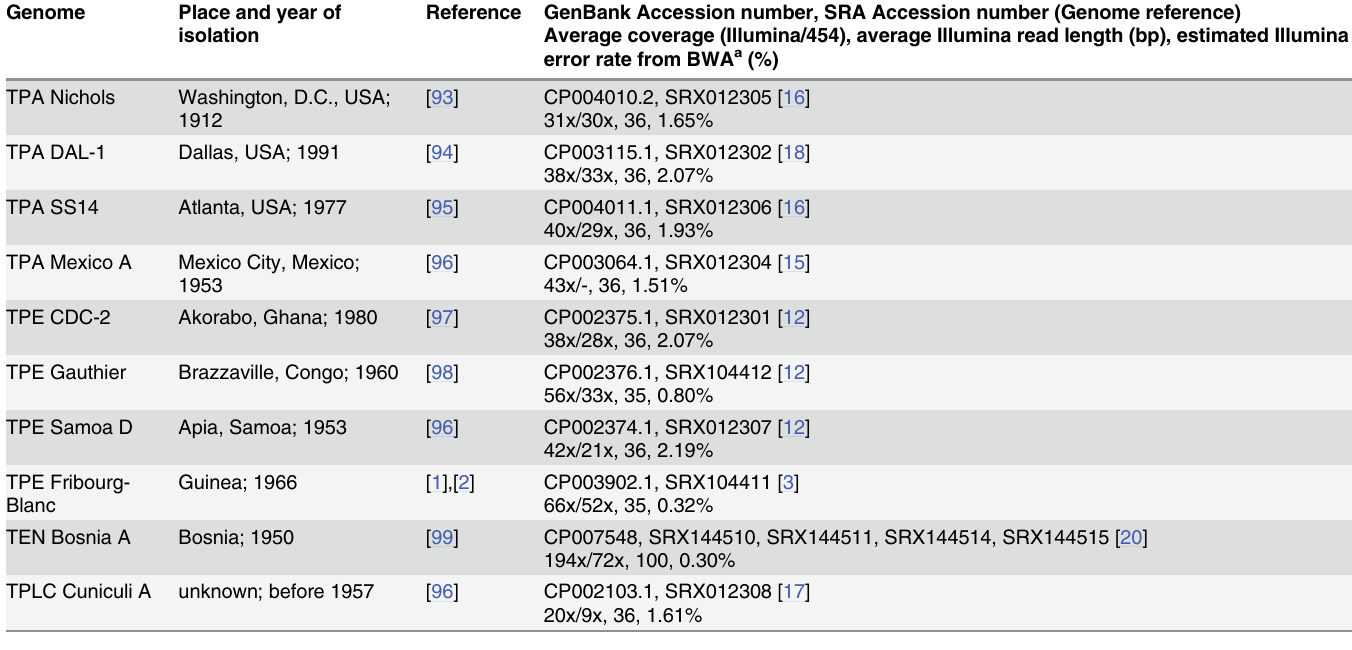
Table 1. Treponemal genomes used in this study. Genome Place and year of